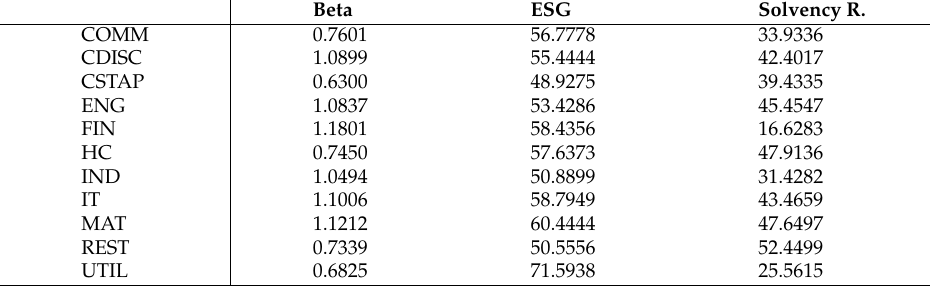
Table 3. Averages of the regressor variables by the sector of the